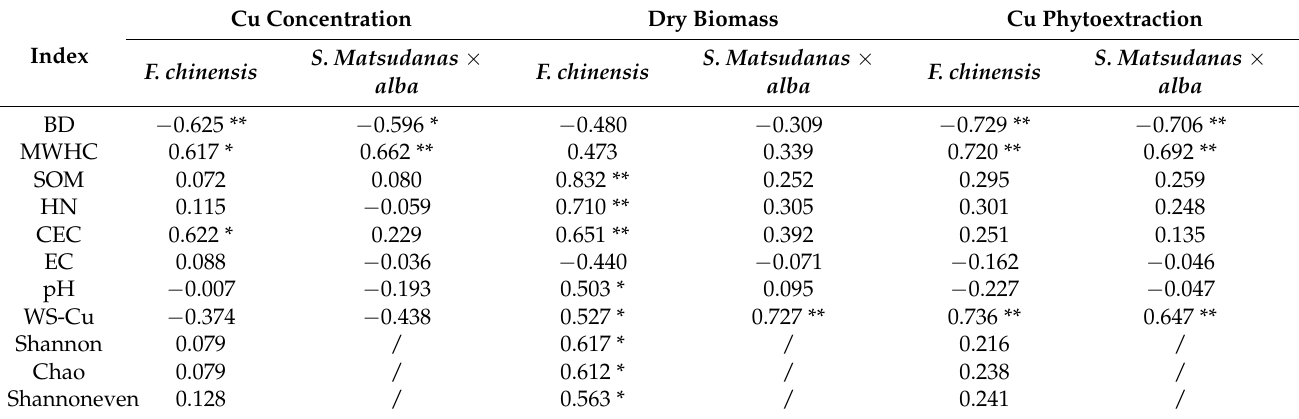
Table 4. Correlation analysis between above-ground indexes and soil characteristics.